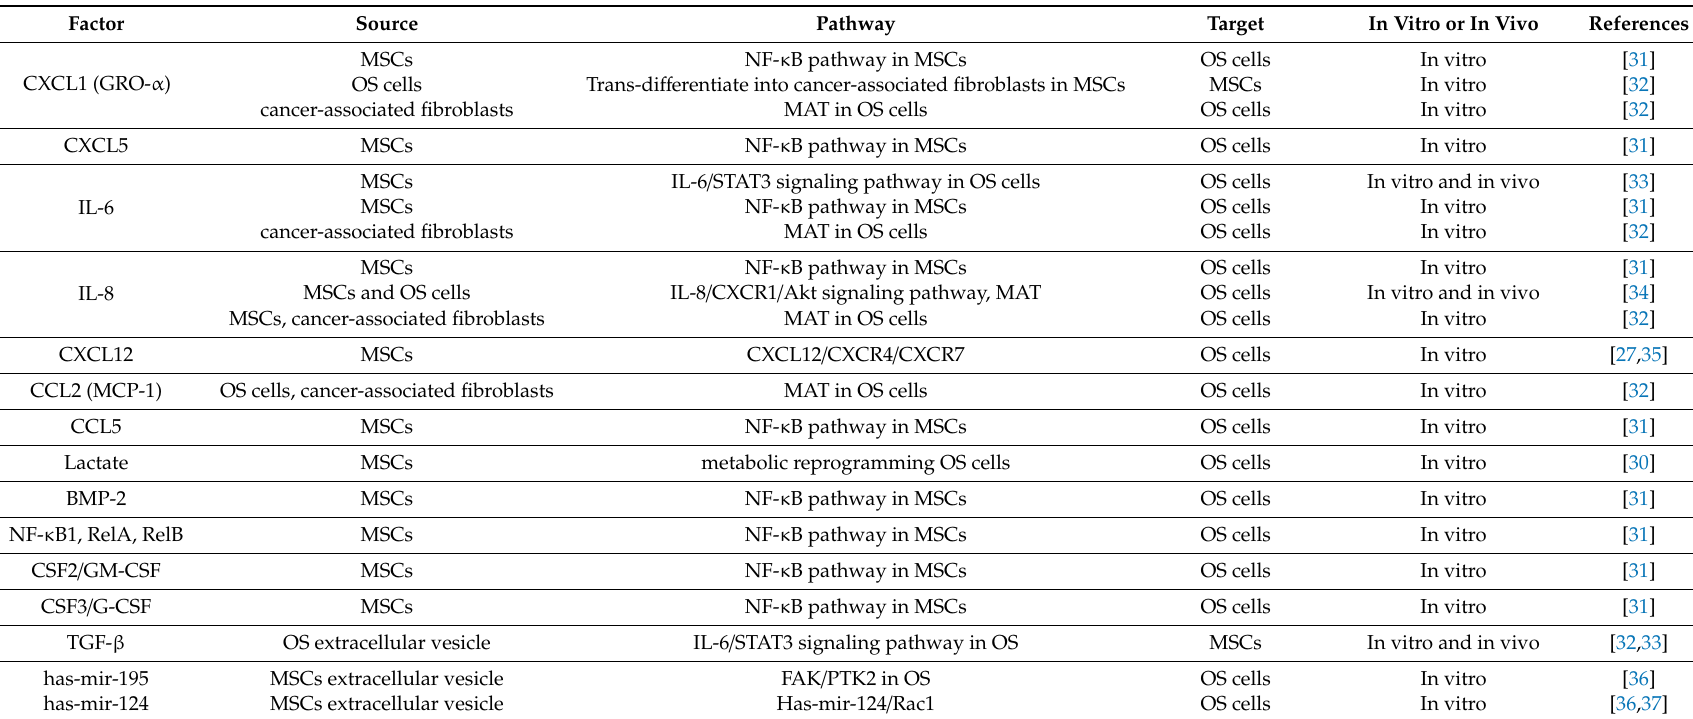
Table 1. Chemokines and other factors that a ff ect OS metastasis in the bone